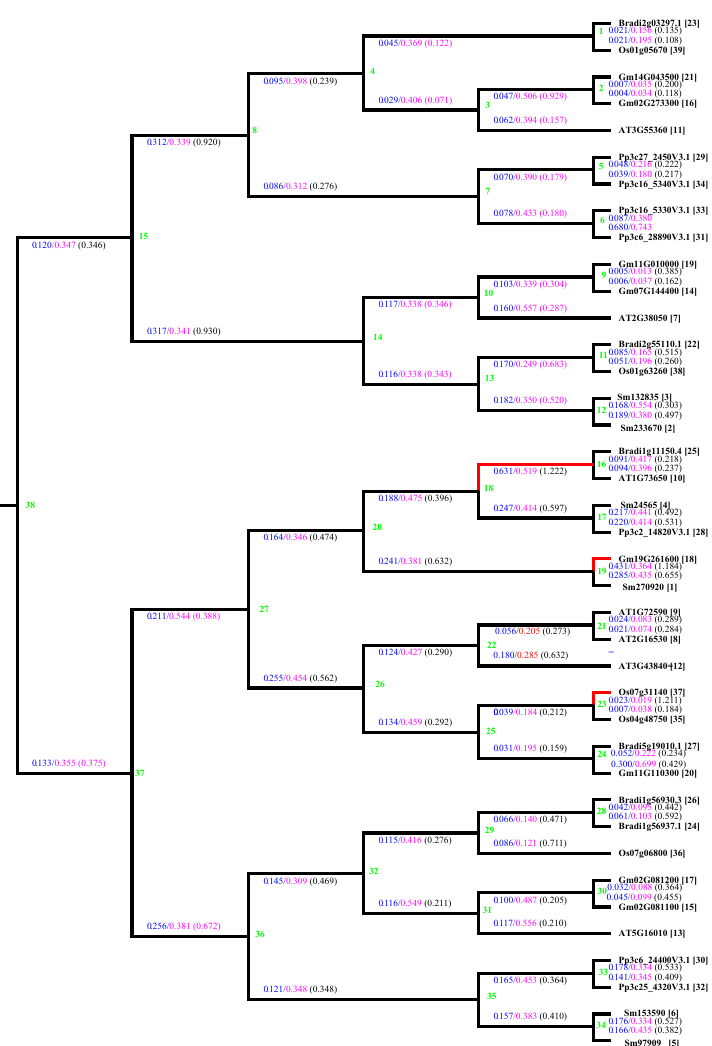
Figure 4. Estimation of Ka/Ks in steroid reductase genes from soybean, common bean, Arabidopsis , rice. The cDNA sequences and amino acid sequences of steroid reductase from moss Physcomitrella patens (Pp), fern Selaginella moellendorffii (Sm), Glycine max (Gm), Arabidopsis thaliana (AT), Brachypodium distachyon (Bradi) and Oryza sativa (Os) were used to estimate Ka/Ks (http://services.cbu.uib.no/tools/kaks). The Ka and Ks values in each node and branch are marked in blue and red, respectively. A total of 38 nodes is shown in green, and the ratios of Ka/Ks in each branch are indicated in parentheses. The ratios of Ka/Ks in most branches are less than one, except for three branches in